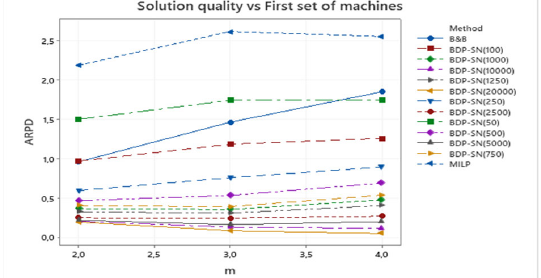
Fig. 7. ARPD variation with respect to the number of jobs Fig. 8. ARPD variation with respect to the first group of